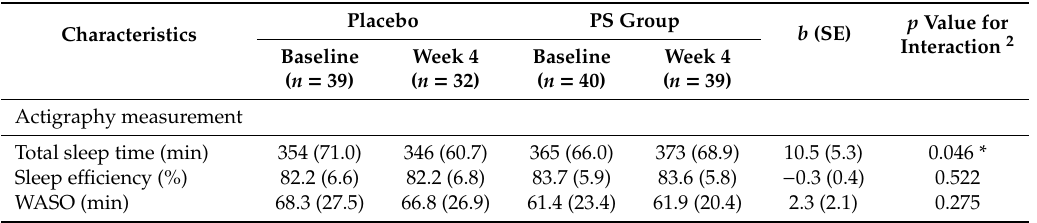
Table 2. Improvement in sleep parameters as measured by actigraphy 1.